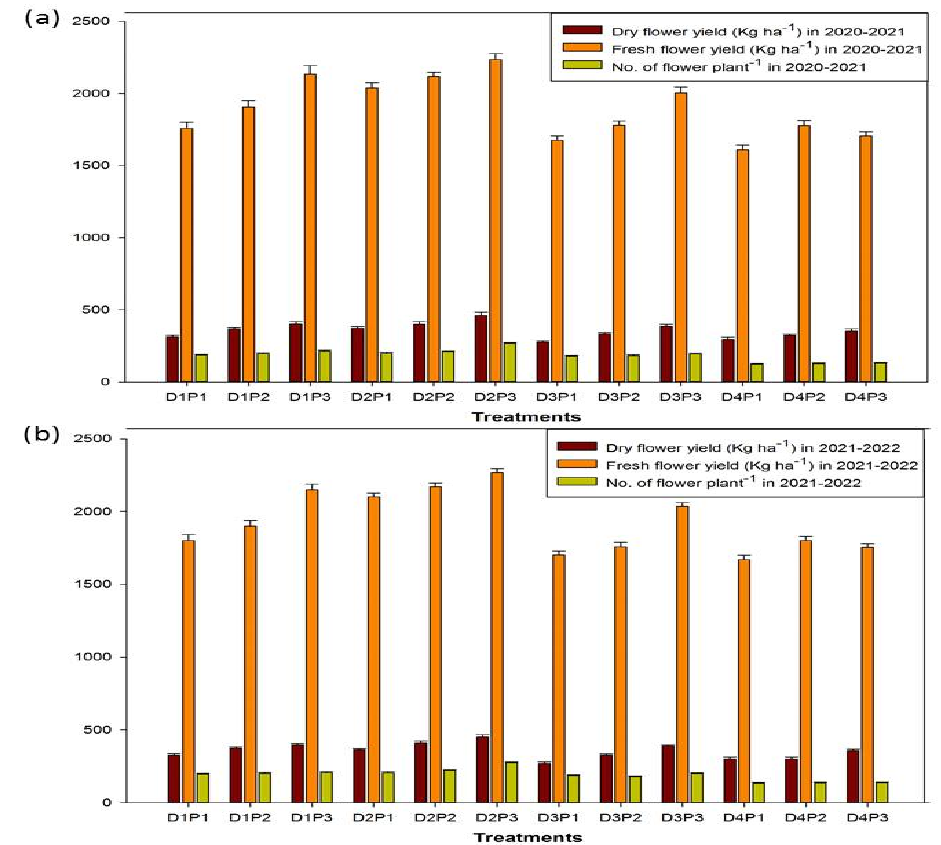
Figure 3. Effect of spacing of plants and date of sowing on the yield of chamomile ( Matricaria cham- omilla L.) during 2020–2021 ( a ) and 2021–2022 ( b ). Table 2. Effect of date of sowing and spacing of plants on essential oil and total oil contents of chamomile ( Matricaria chamomilla L.) during the year 2020–2021 and 2021–2022. Treatment Symbols